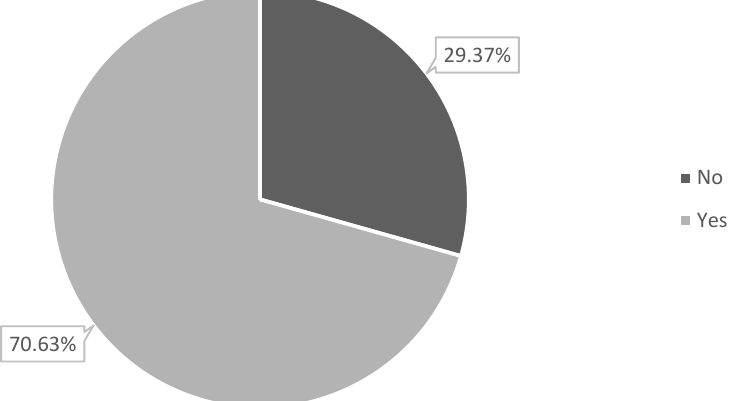
Figure 1. Parental hesitancy towards COVID-19 vaccination among children with CP. 3.4. Factors Correlated with Parental Hesitancy Towards COVID-19 Vaccination The bivariate association between the mean PACV score and statistically significant covariates is presented in Table 4. Egyptian parents, those who had a history of COVID- 19-related deaths in their families, incomplete or lack of parental COVID-19 vaccination, incomplete childhood routine immunization, and lack of parental intention to give their child the COVID-19 vaccine were significantly associated with higher mean PACV scores ( p < 0.05) (Table 4). Table 4. Parental hesitancy towards COVID-19 vaccination using PACV ( n = 321). Covariates